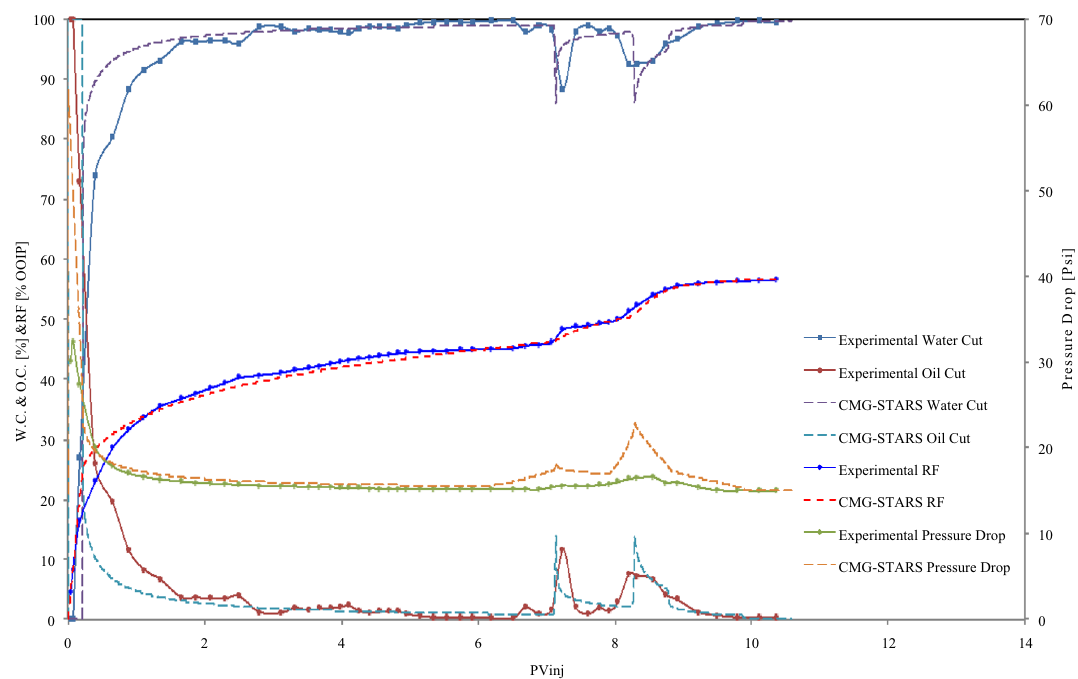
Fig. 7 History matching of the experimental and simulation cumulative oil recovery, water cut, oil cut, and pressure drop for 1PV Alkali + Ionic Liquid slugs Fig. 8 History matching of the same simulator and laboratory core